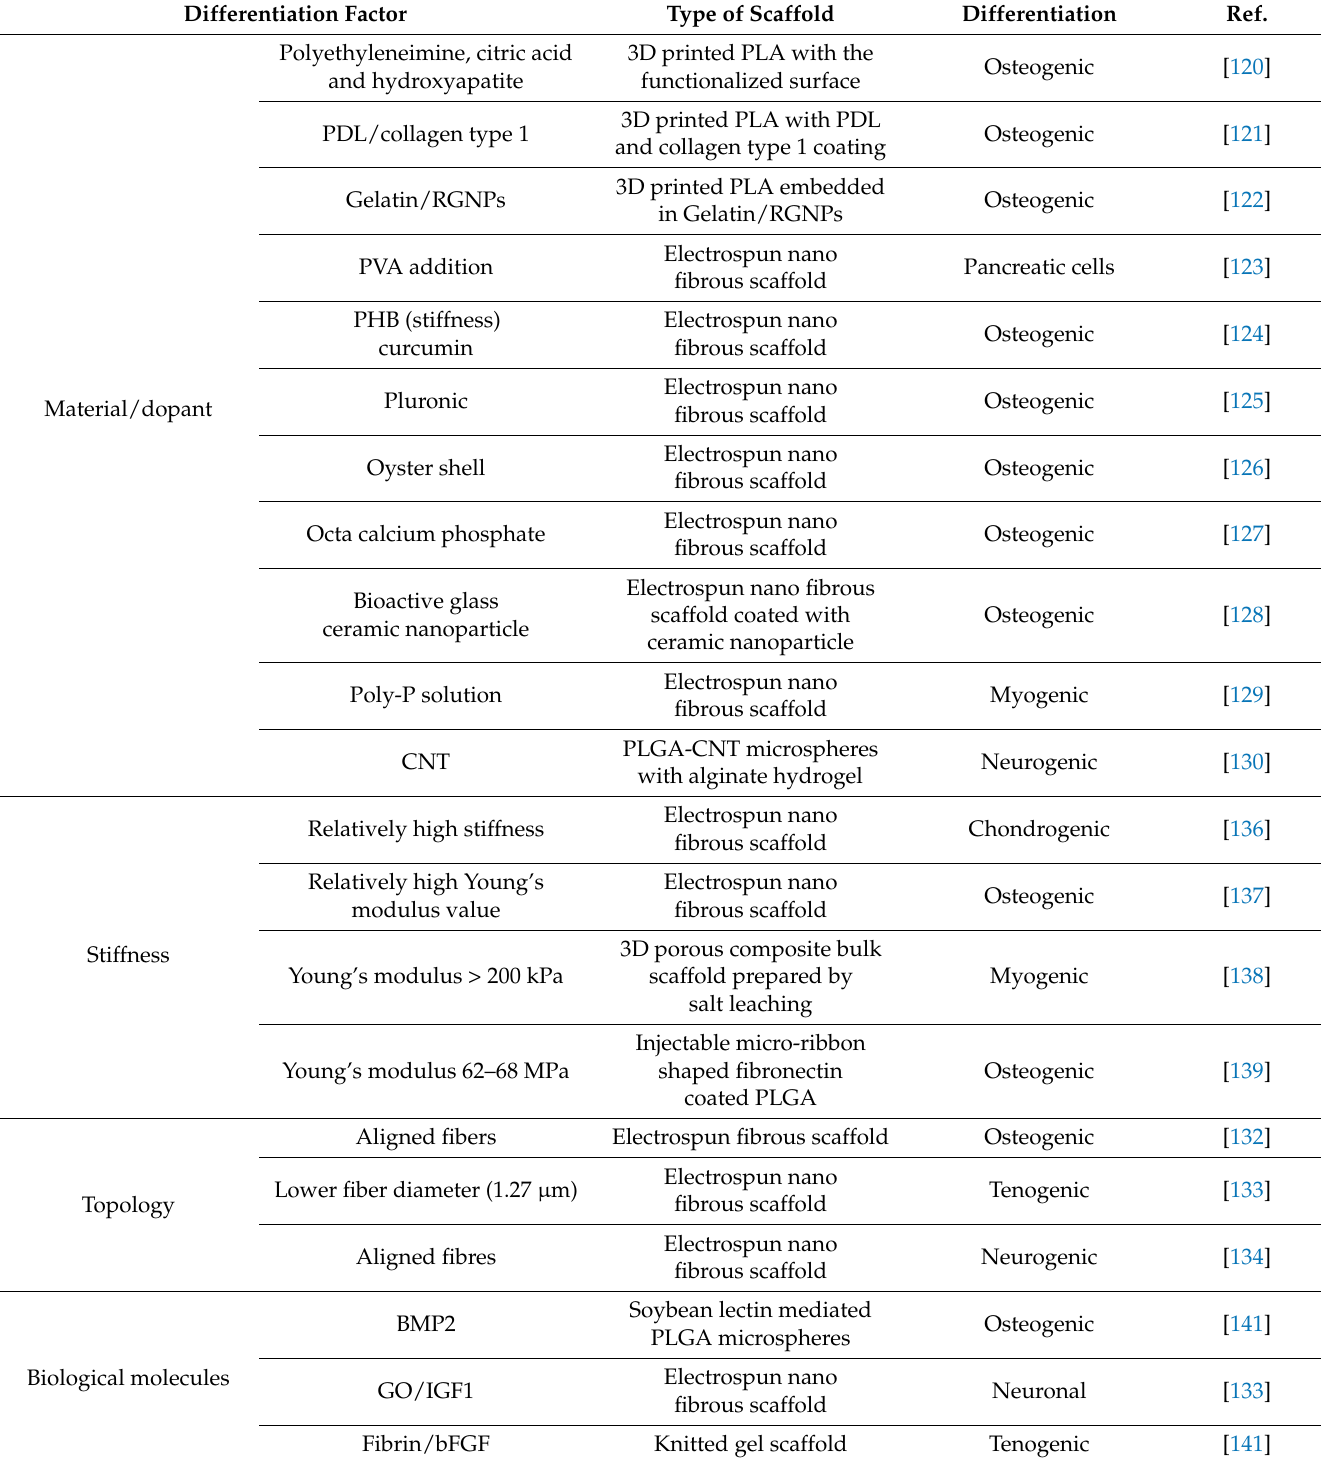
Table 2. Influence of PLA and its derivatives on cell